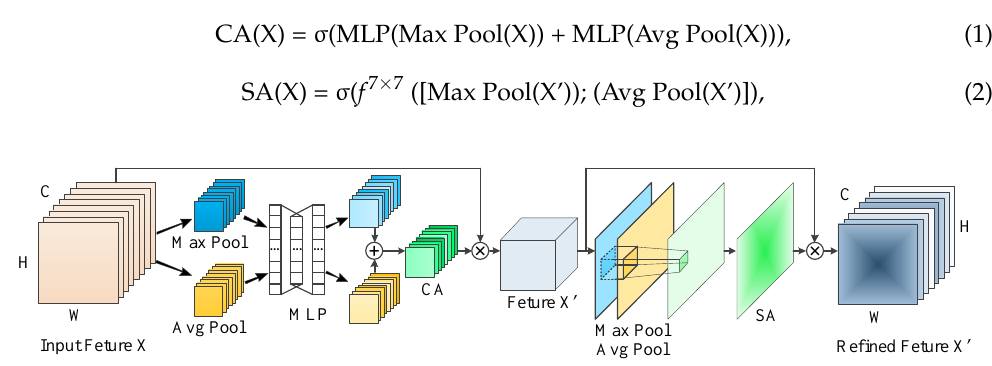
Figure 3. Convolutional Block Attention Module (CBAM).